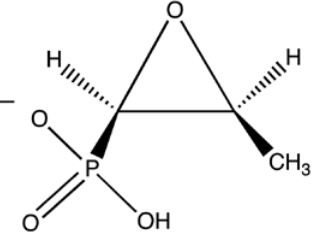
Figure 7: Chemical structure of the antibiotic fosfomycin.